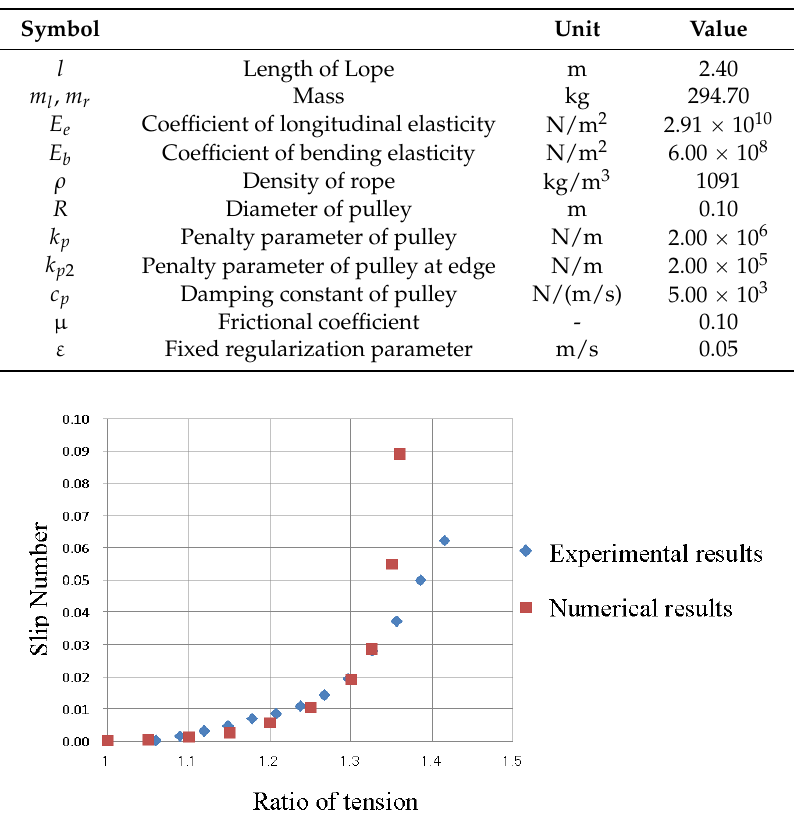
Table 2. Parameters for numerical simulation.